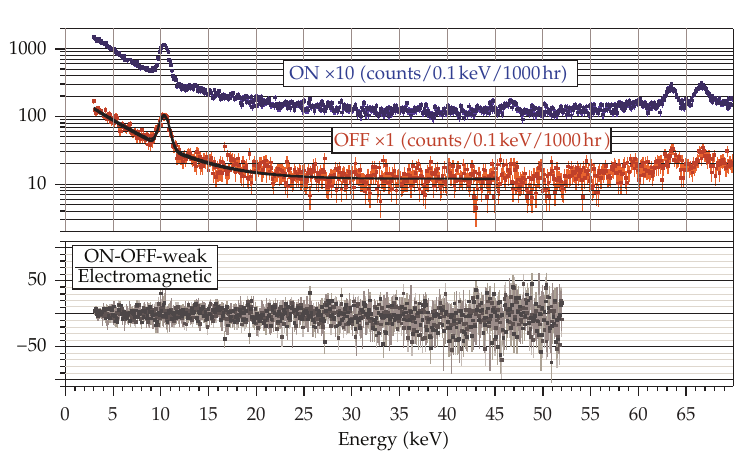
Figure 7: Fragments of the experimental ON and OFF spectra (cid:2) top (cid:3) and their di ff erence normalized by the electromagnetic cross-section (cid:2) bottom (cid:3)